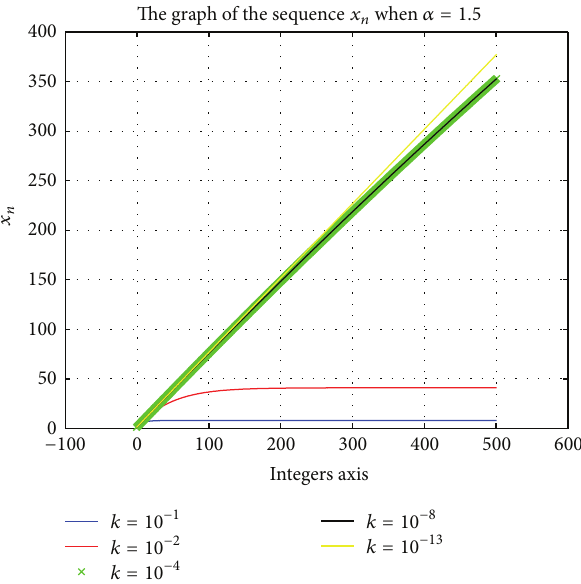
Figure 1: When 𝑚 = 1 and 𝑘 → 0 the positive solution is